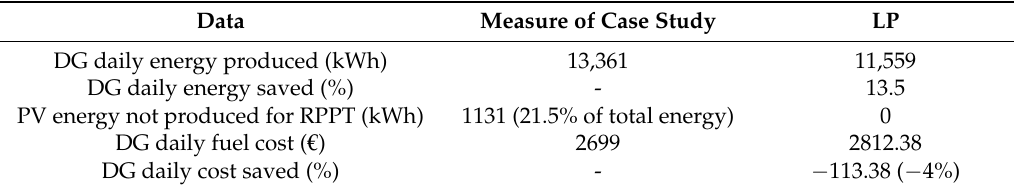
Table 5. Comparison between case study and LP model’s results.